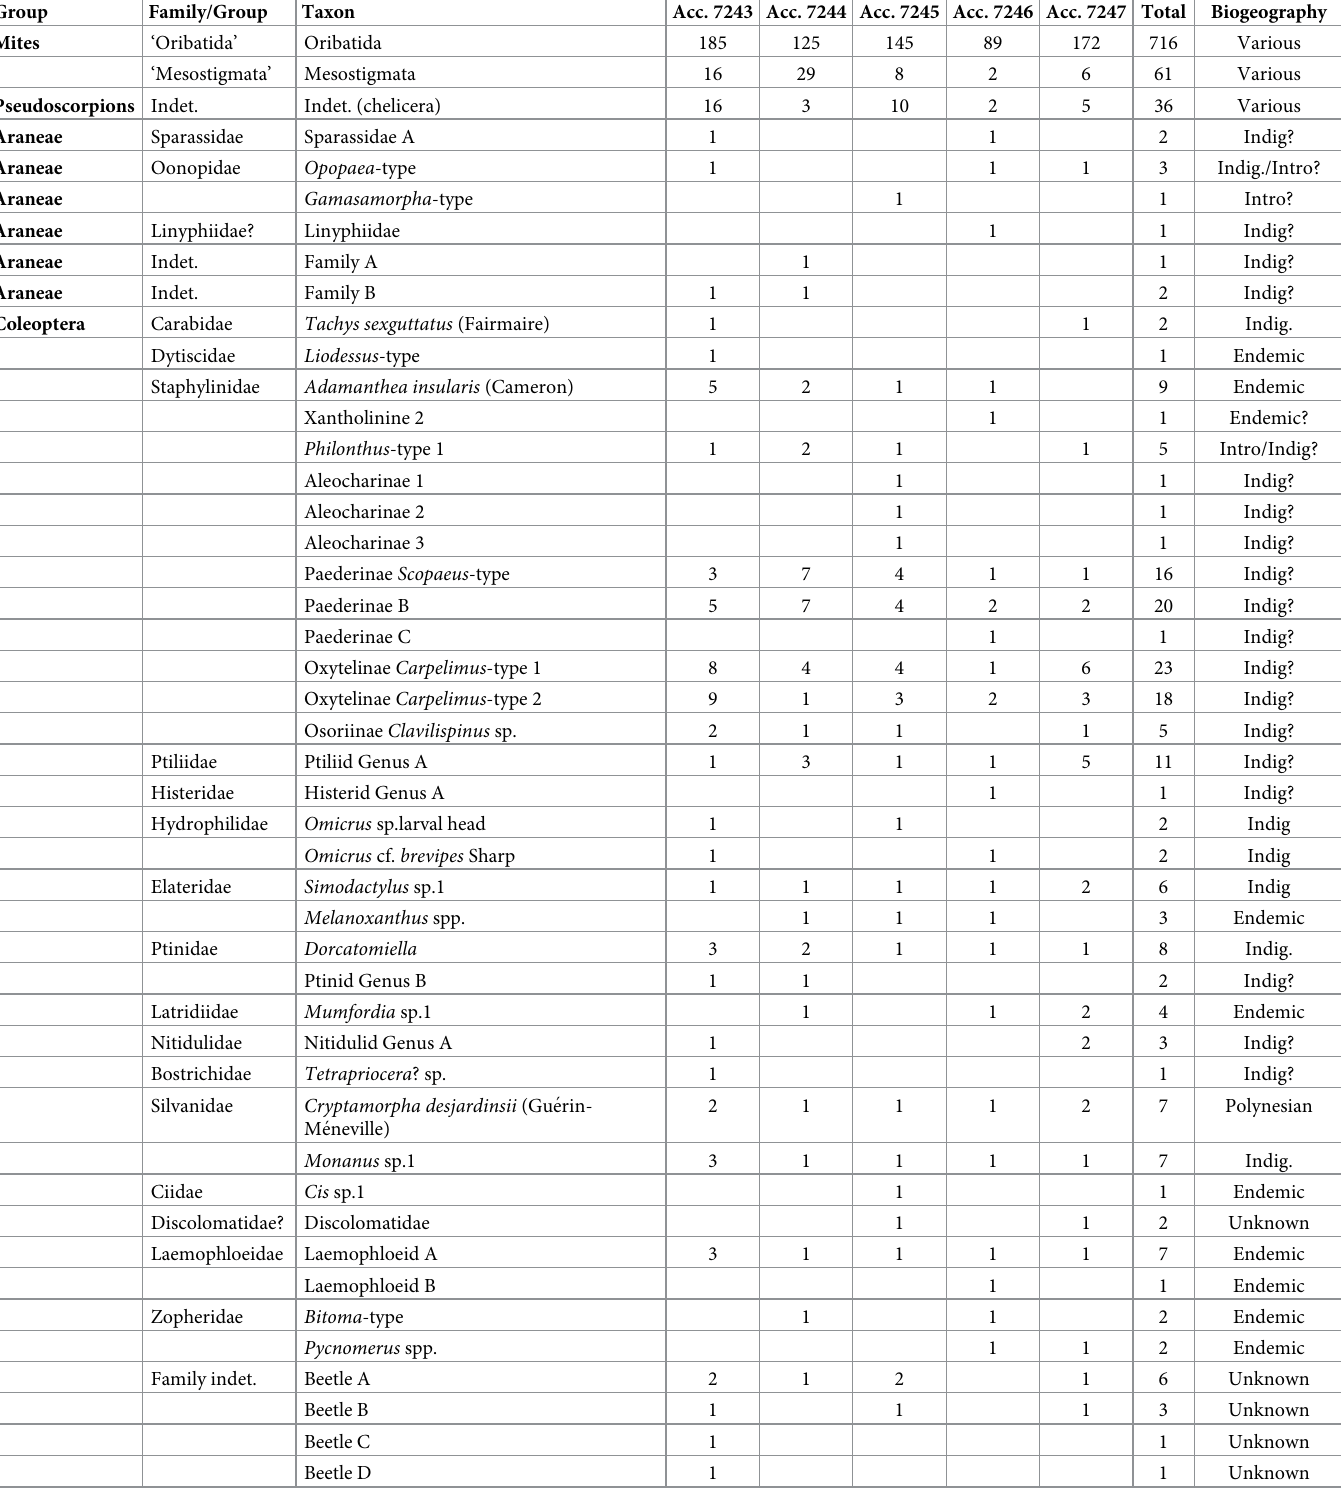
Table 5. Summary of identified arthropod